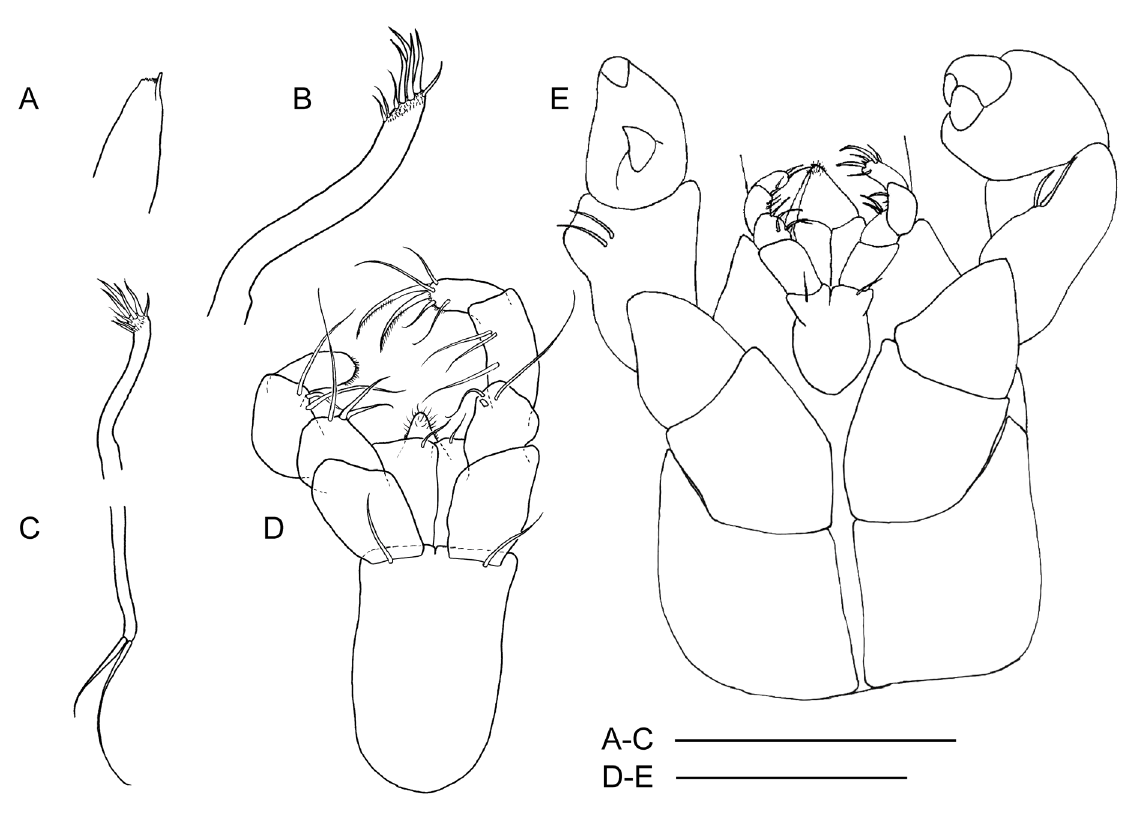
Fig. 4. Paranarthrura cousteaui sp. nov. Dissected paratype, adult, ♀ (DBUA0002189.03). A . Right mandible. B . Maxillule endite. C . Maxillule. D . Maxilliped (right palp-4 setae not drawn) and labrum. E . Ventral view of cephalothorax. Scale bars: A, B, D = 50 μm; C, E = 100